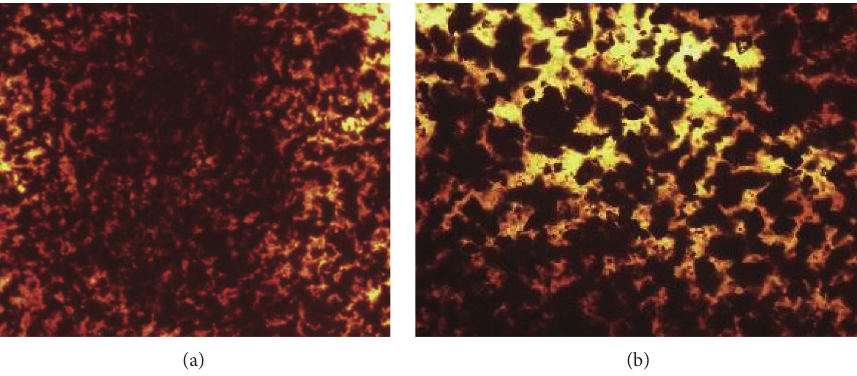
Figure 1: Preactivated (a) and activated (b) BRA microscopic images.